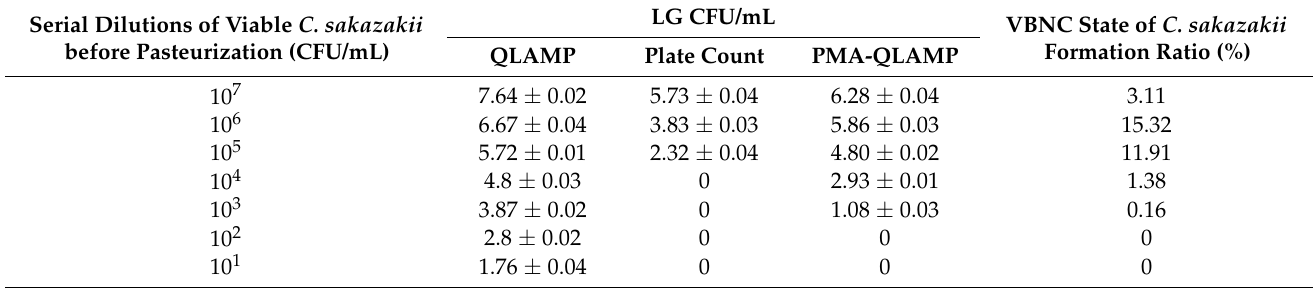
Table 3. Formation of C. sakazakii VBNC state during pasteurization.